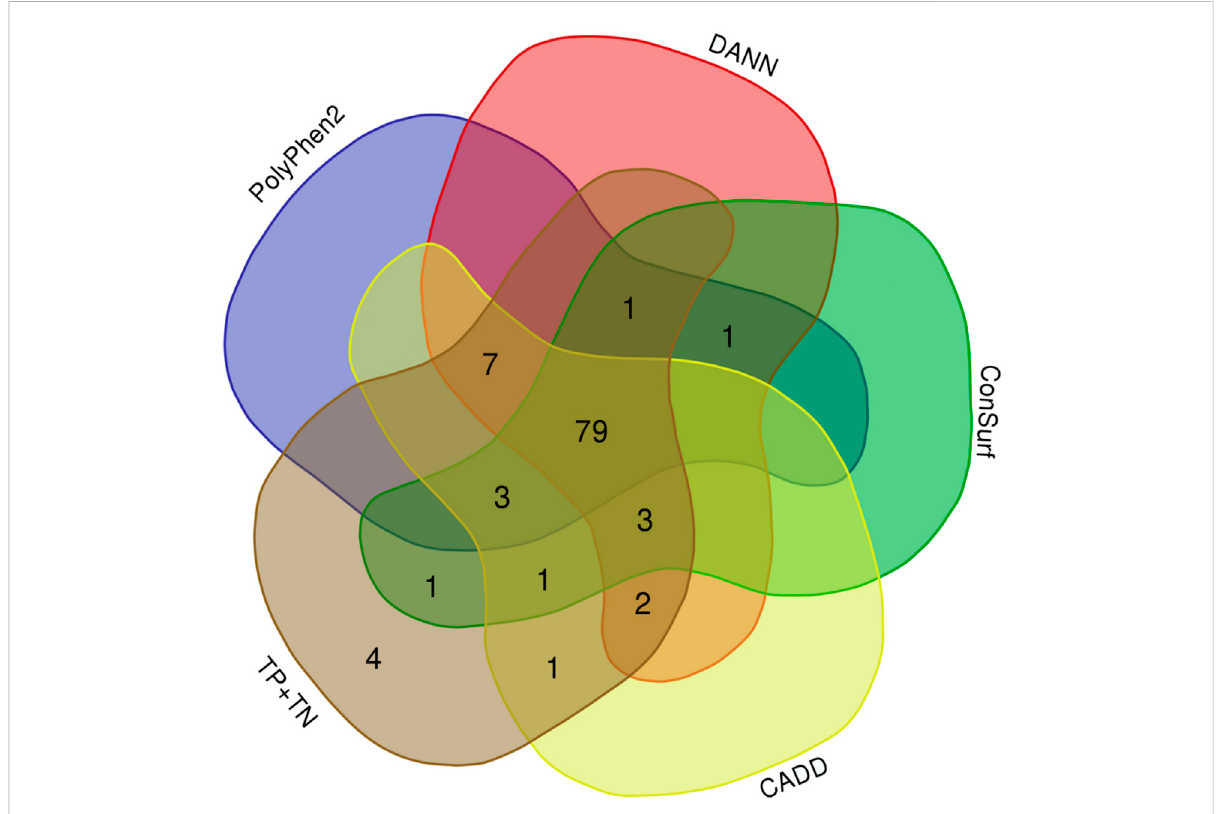
FIGURE 3 Overlaps of the hit for four predictors with good-excellent performance for SNVs on CYP21A2. Total, indicates all 103 SNVs tested. (Image generated with